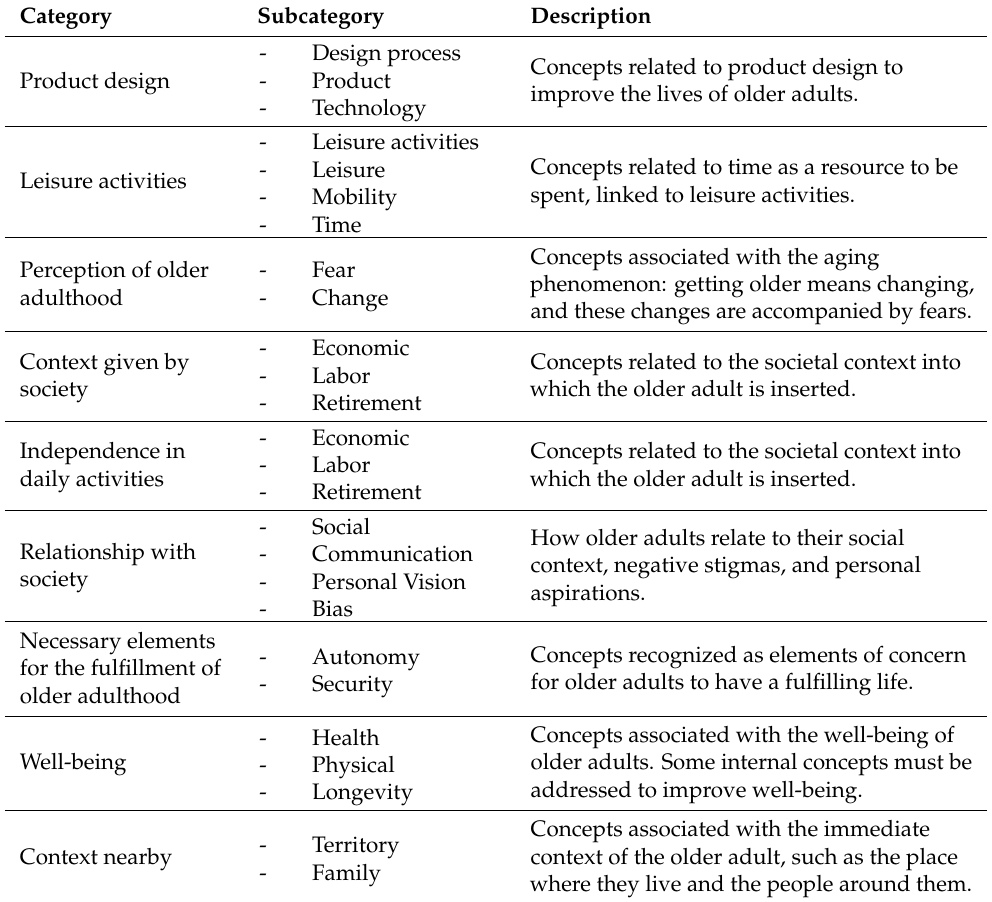
Table 5. Categories and subcategories extracted from the